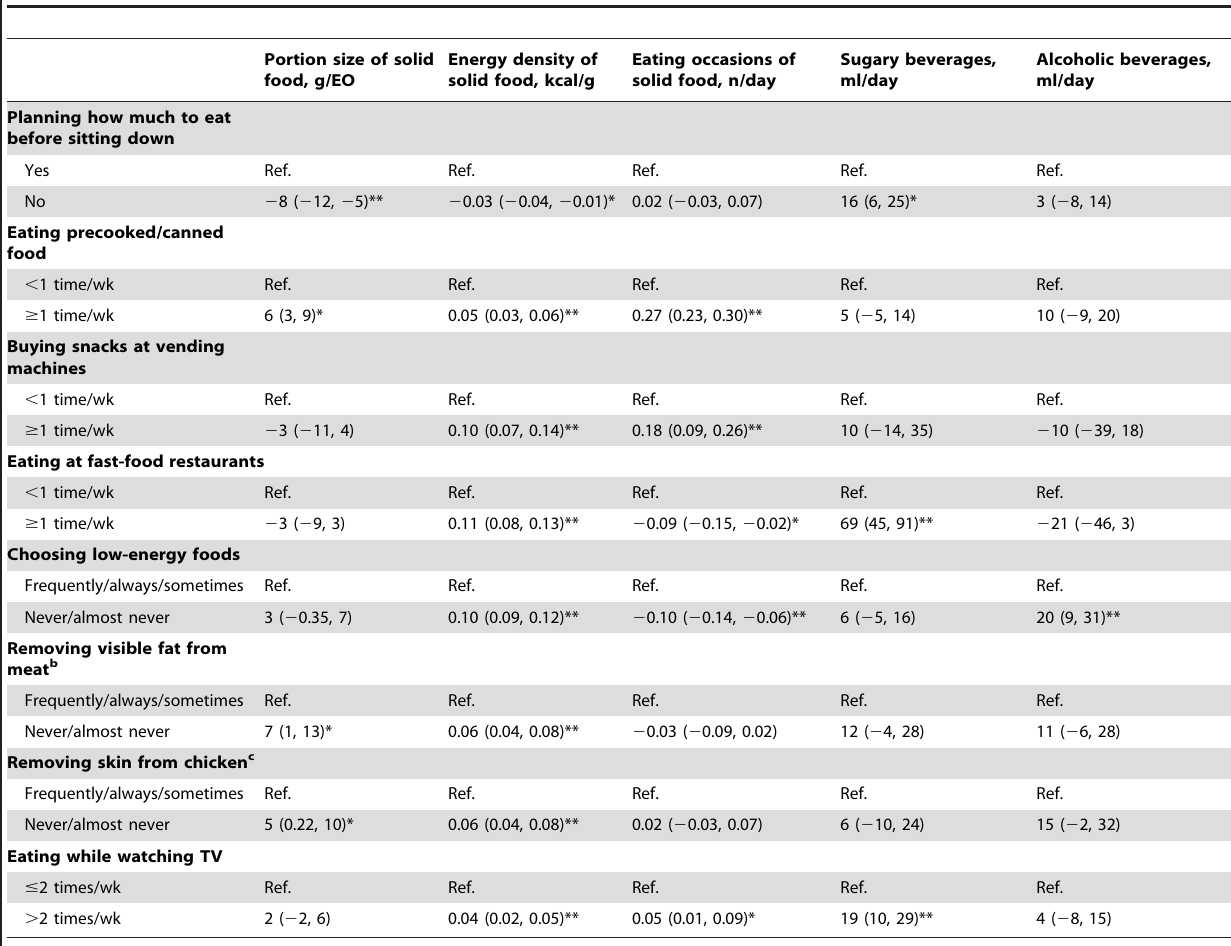
Table 3. Association of individual obesity-related eating behaviors with portion size, energy density of foods, number of eating occasion, and beverage consumption a